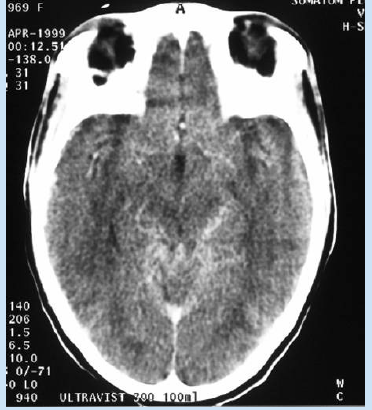
Fig.1. CT scan showing basal meningeal enhancement in a patient with presumed